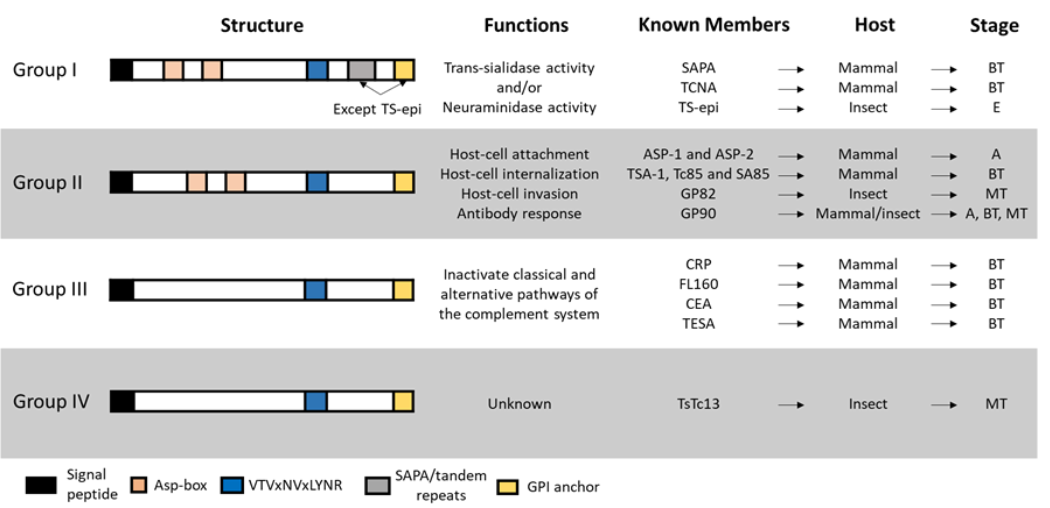
Figure 4. First classification of TS members. Four groups were described according to their sequence similarity and functional properties. The structure and functions of each group are displayed as well as the known members with their host and parasite-stage in which they are expressed. BT: